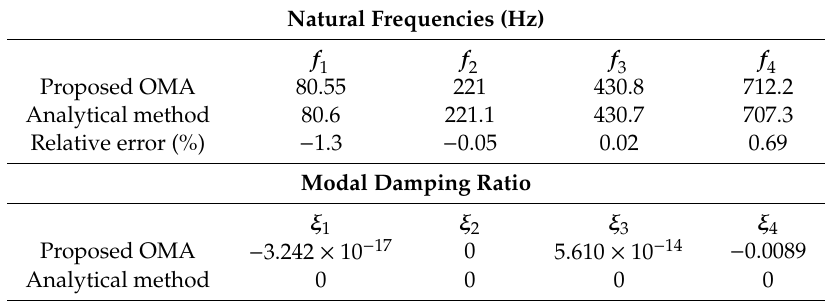
Figure 3. The time series and the stabilization diagram of the output: ( a ) The time series of the excitation; ( b ) The stabilization diagram: black asterisk-frequency variation ratio [0–0.5%], Pinkdot_frequency variation ratio [0.5–1%]. Table 2. The comparison of the estimated natural frequencies and modal damping ratios from present OMA with the results from analytical method.